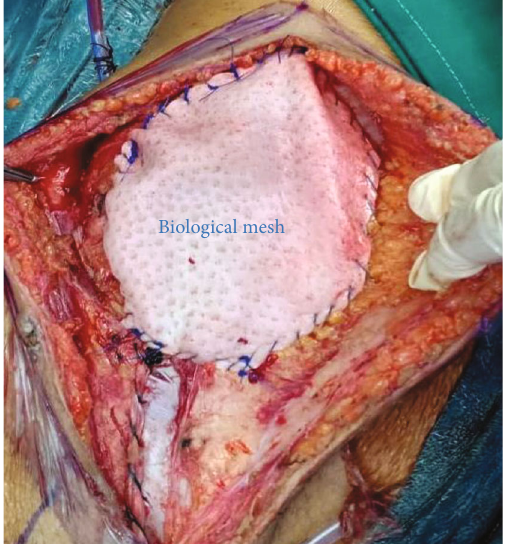
Figure 5: Partial closure of wound using a biological mesh in order to reduce tension in the wound and prevent increased intra- abdominal pressure secondary to the large allograft